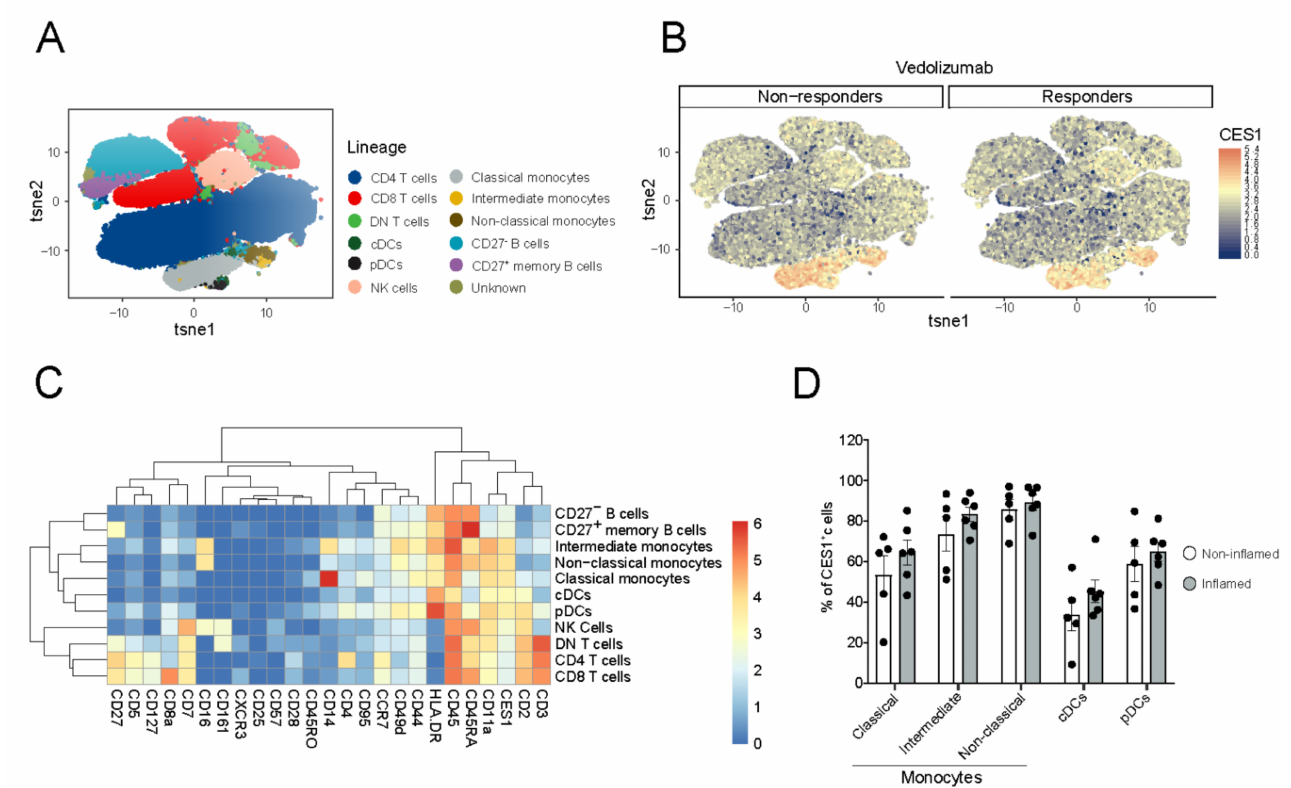
Figure 2. CES1 is expressed in the mononuclear myeloid cells of peripheral blood from CD pa- tients independent of therapy response. ( A ) PBMCs from 11 CD patients (vedolizumab responders; n = 5, and vedolizumab non-responders; n = 6) were barcoded, stained, and pooled for CyTOF and visualized in a tSNE plot after mass cytometry analysis. B cells, CD4 T cells, CD8 T cells, DN T cells, NK cells, classical monocytes, intermediate monocytes, non-classical monocytes, cDCs, and pDCs were identified. ( B ) CES1 expression intensity in PBMCs was demonstrated among identified cell clusters in ( A ); responders (non-inflamed) and non-responders (inflamed) are displayed separately. ( C ) A heat map showing expression intensity of different (lineage) markers in relation to the identified cell clusters in ( A ). ( D ) Percentages of CES1 + cells are shown among identified mononuclear myeloid cells subsets (pDCs, classical monocytes, cDCs, intermediate monocytes, non-classical monocytes); responders (non-inflamed) and non-responders (inflamed) are